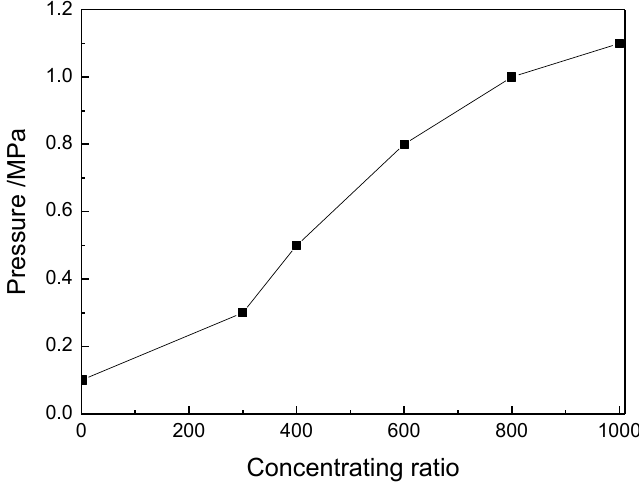
Figure 6. Maximum pressure in the reactor under different concentrating ratios.